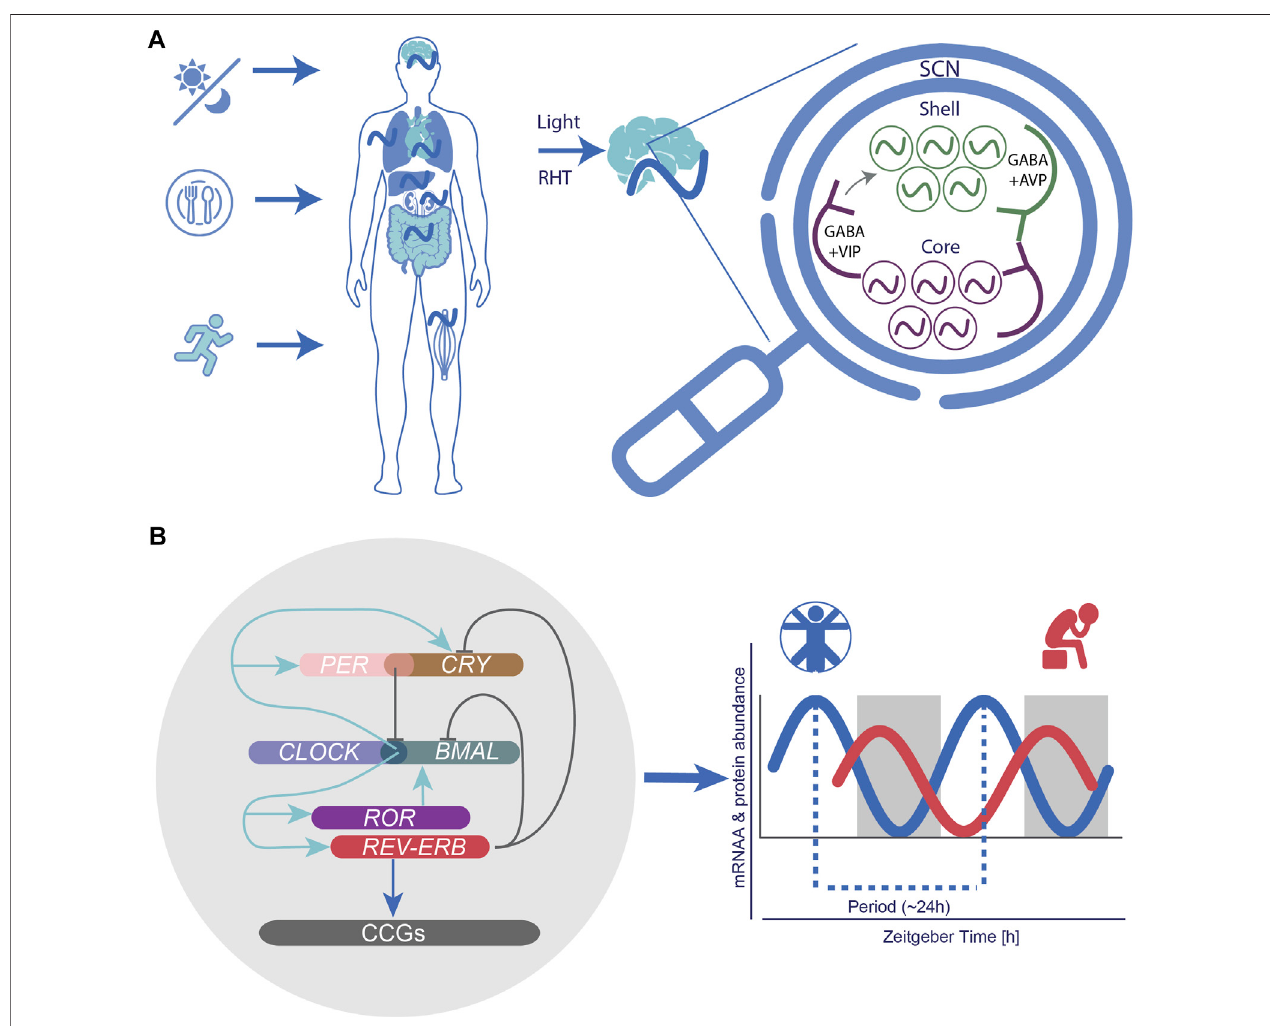
FIGURE 2 | The circadian system as a neural and molecular network and implications for circadian medicine. (A) Following light exposure, activated intrinsic photosensitive ganglion cells transmit photic information to the suprachiasmatic nucleus SCN via the retinohypothalamic tract (RHT). The SCN synchronizes peripheral clocks throughout the body via endocrine, neuronal routes and behavioural outputs. The SCN is organized in a “ core ” (with VIP expressing neurons) and a “ shell ” region (with AVP expressing neurons), which ensure neuronal coupling. (B) At the molecular level the circadian network is formed by intricated self-sustained feedback loops of core-clock elements (CLOCK, BMAL, PERs, CRYs, RORs, and REV-ERBs), which drive 24-h rhythmic oscillations at the mRNA and protein level of several target genes.